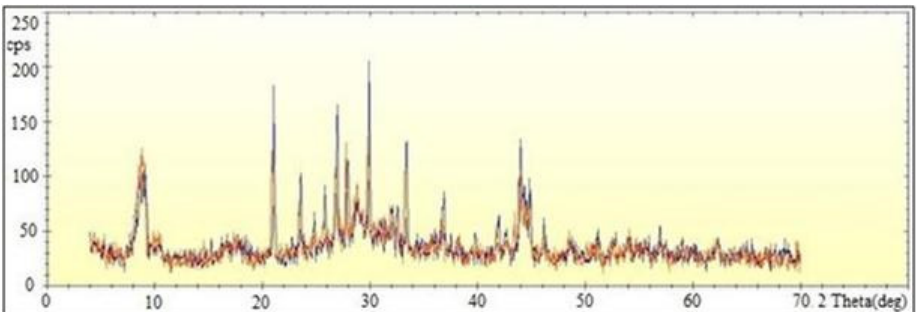
( a ) working electrolyte temperature of T1 = 63 ± 2 °C and ( b ) working electrolyte temperature of T2 = 73 ± 2 °C.